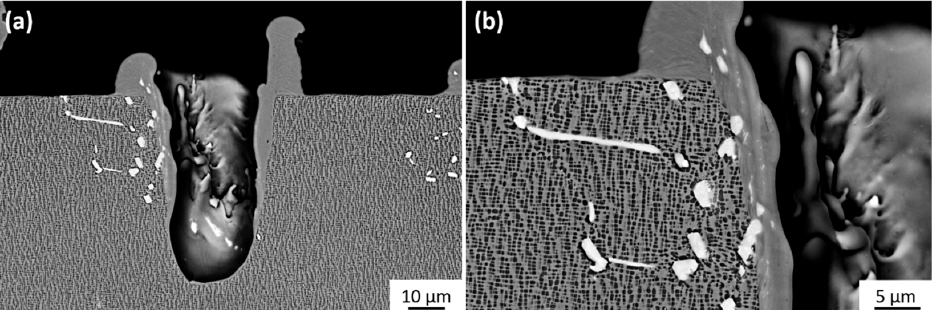
Figure 6. Non-melted carbides observed on MAR M200 + Hf + AgT specimens: ( a ) pattern, ( b ) magnification on a melted/re ‐ solidified area.